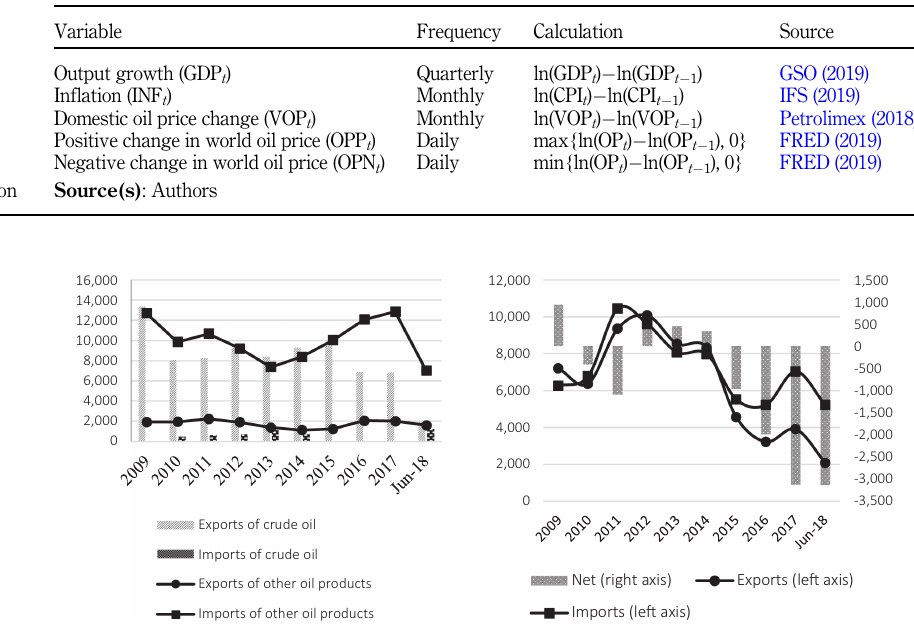
Figure 1. Exports and imports of oil in